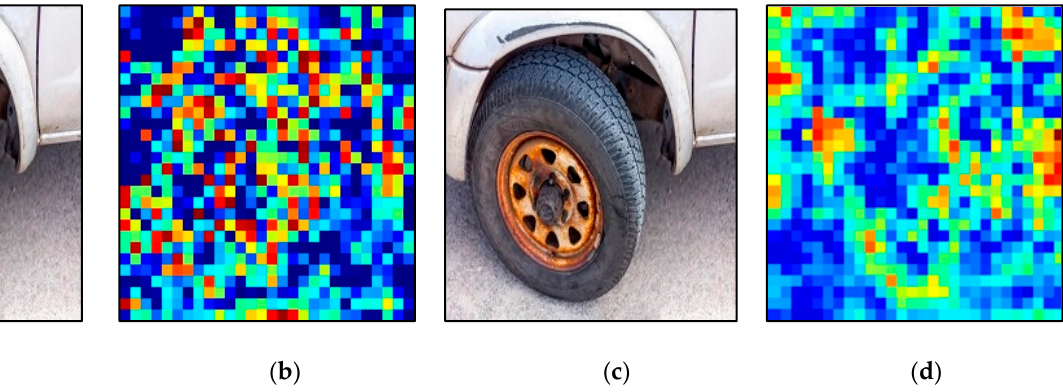
Figure 1. ( a ) Original image ( b ) feature-map ( c ) adversarial attack ( d ) attack feature-map.